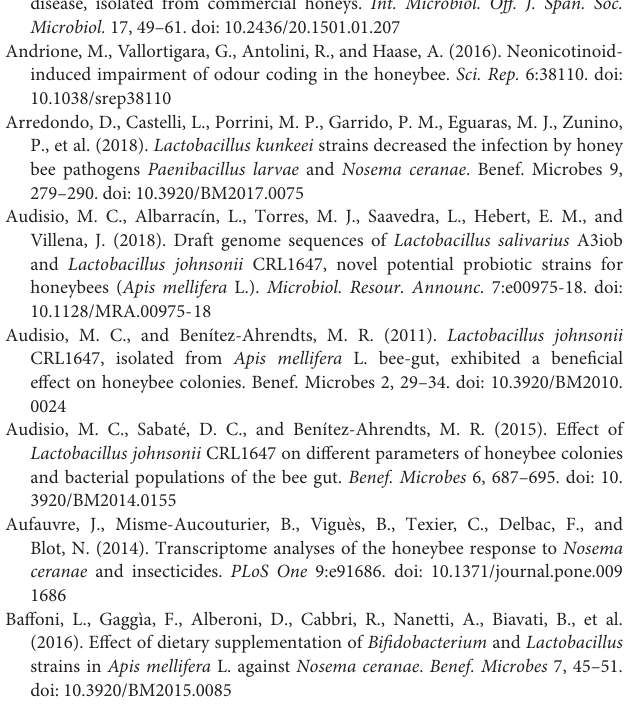
TABLE S1 | Complete adult and larval LD50 values for multiple